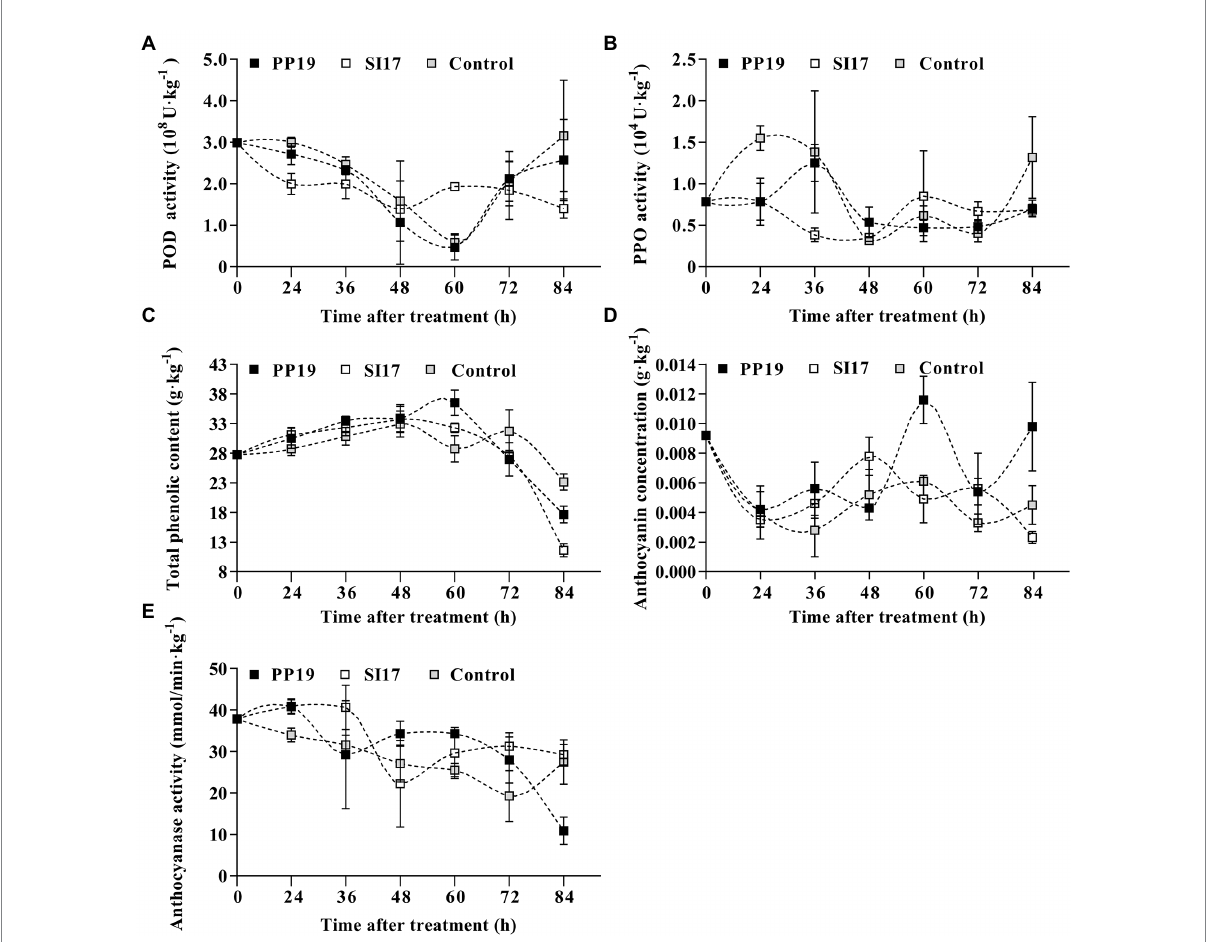
FIGURE 4 Activity or concentration changes in the litchi fruit pericarp influenced by PP19 and SI17 treatments. POD (A) and PPO (B) activity, TPC (C) and anthocyanin concentration (D) , and ANT activity (E) . Bacteria (5 × 10 7 CFUs mL − 1 ) were sprayed onto ‘Feizixiao’ fruit (about 80% ripeness) in LTs (Danzhou, Hainan province). Measurement was performed at 0, 24, 36, 48, 60, 72, and 84 h after treatment. Data are presented as means of replicates ± standard errors; different letters indicate significant differences between treatments according to LSD test at p <